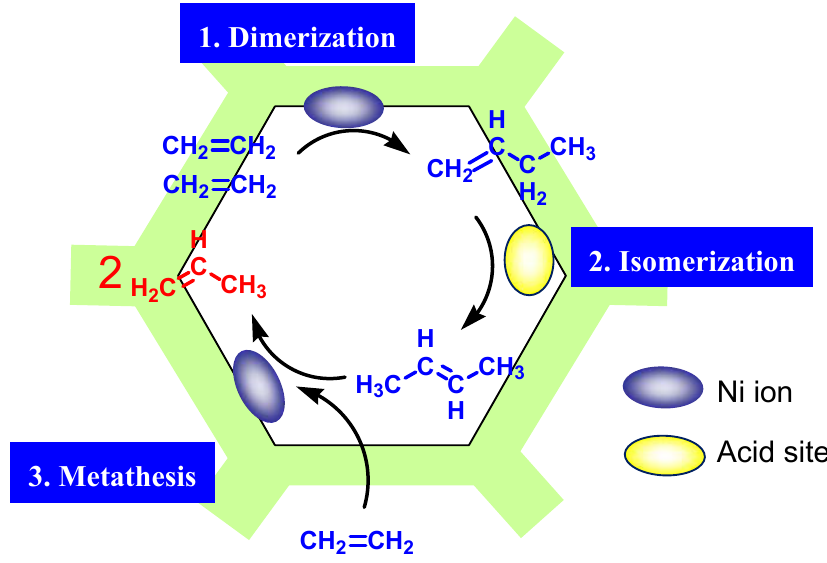
Figure 3. Proposed reaction mechanism for the conversion of ethene to propene on Nickel ion-loaded